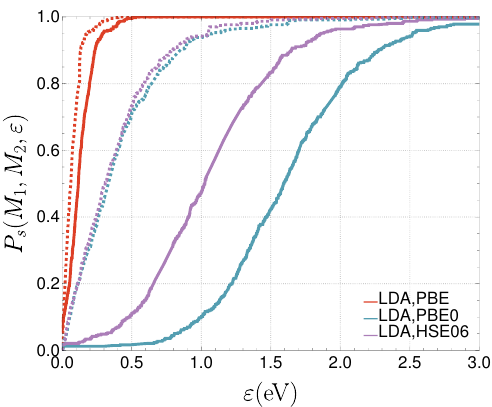
Figure 7. Probabilities P s ( M 1 , M 2 ; (cid:101) ) that a pair of methods ( M 1 , M 2 ) yields similar results (within (cid:101) ) for (LDA and PBE), (LDA and PBE0), and (LDA and HSE06). The dashed curves are obtained after centering the errors.